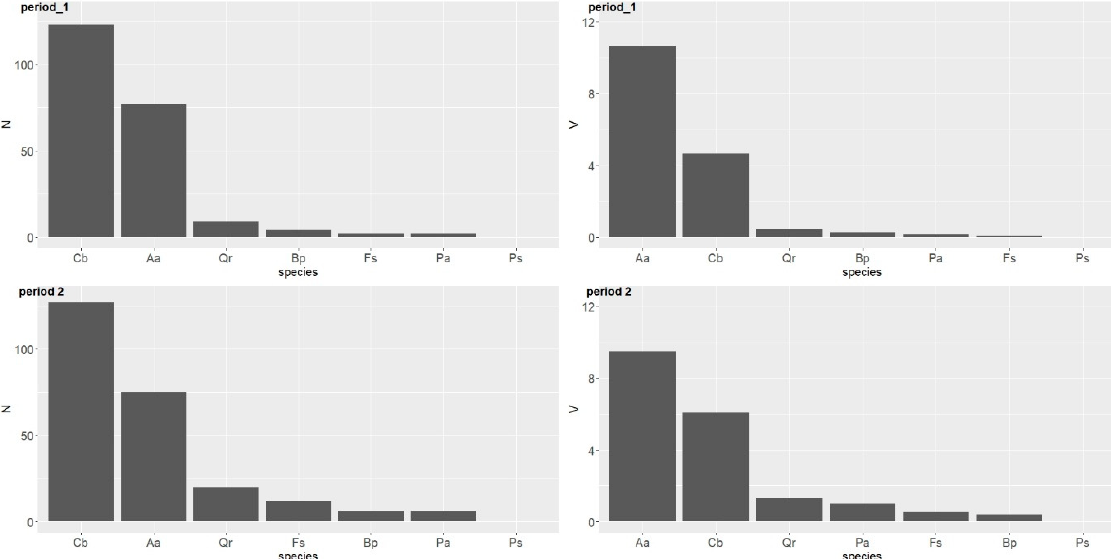
Figure 7. Number (ha − 1 ) and volume (m 3 ha − 1 ) of ingrowths by tree species over two periods in the uneven-aged forest located in the Unieszów Forestry Range.